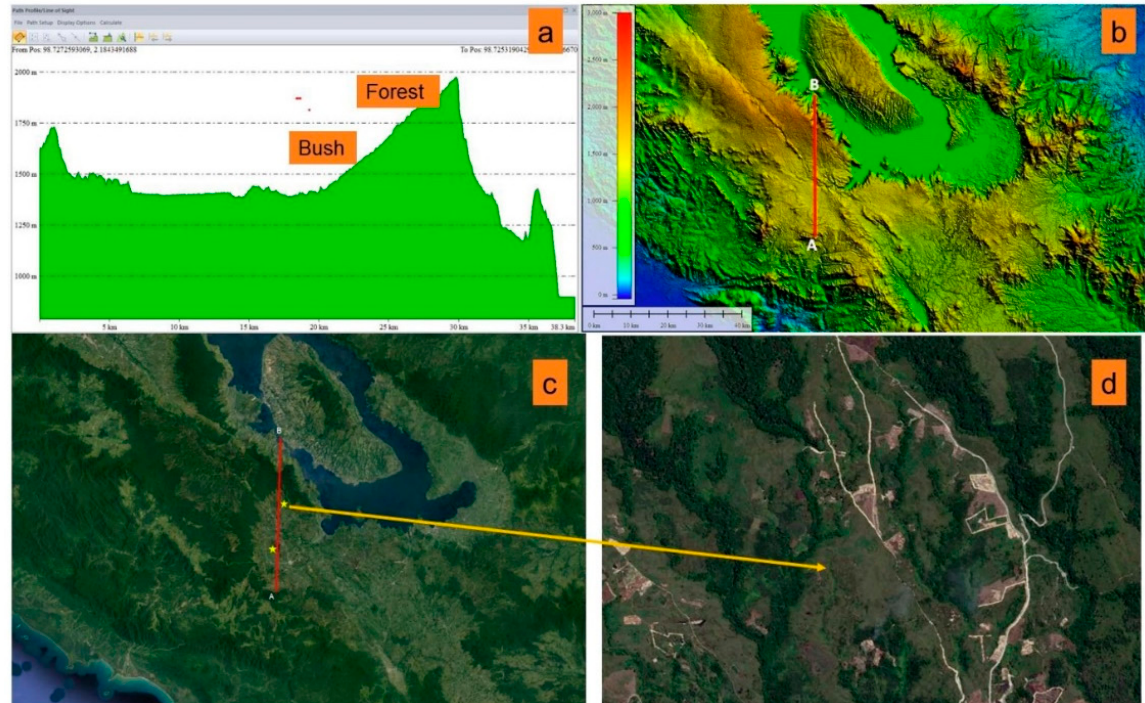
Figure 5. Path profile of global mapper ( a , b ) (elevation), Mosaic SPOT 6 at a scale of 50,000 ( c ), bush-shrub at a scale of 5000 ( d ). Location in Humbang Hasundutan Regency, North Sumatera (Toba Lake), elevation of >1400 m above sea level, annual rainfall >2000 mm (wet climate).